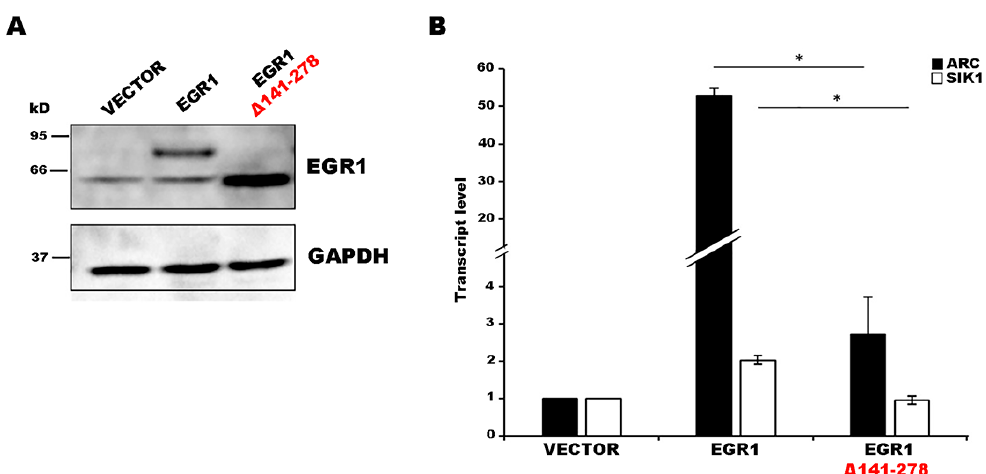
Figure 3. Expression pattern comparison in EGR1 and EGR1 ∆ 141–278 iper-expressing cells. ( A ) Analysis of the isoforms iper-expression in HEK293T cells transfected with both EGR1 constructs and an empty plasmid by Western blotting. The level of Glyceraldehyde-3-phosphate dehydrogenase (GAPDH) protein was used as a loading control. ( B ) Expression level change for activity regulated cytoskeleton associated protein ( ARC ) and salt inducible kinase 1 ( SIK1 ) transcripts in EGR1 and EGR1 ∆ 141–278 iper-expressing cells. Gene expression level was normalized to the reference transcript GAPDH and calculated with the 2 − ∆∆ Ct method. The sample transfected with the empty vector was used as a calibrator. The results from independent biological replicates were expressed as the mean of fold change ± SEM (standard error of the mean). Statistical analysis of the qPCR data was carried out using a two-tailed t-test. Significance of difference in fold change (* p < 0.05) is shown. For both genes, the canonical EGR1 isoform was able to significantly increase transcription whereas the alternative isoform lacked the ability to fully activate transcription (Figure